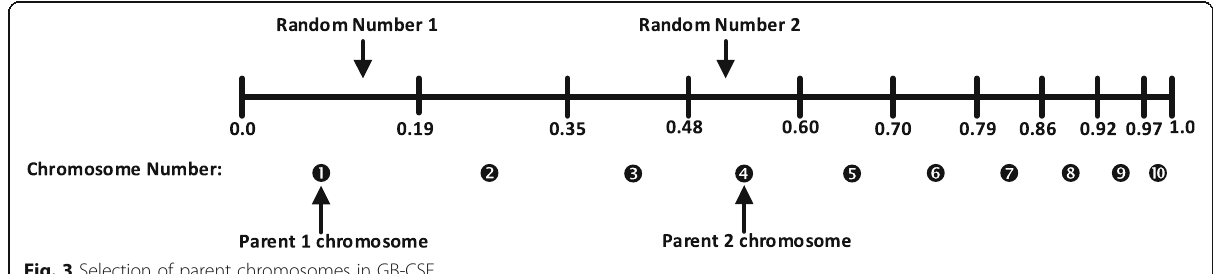
Fig. 3 Selection of parent chromosomes in